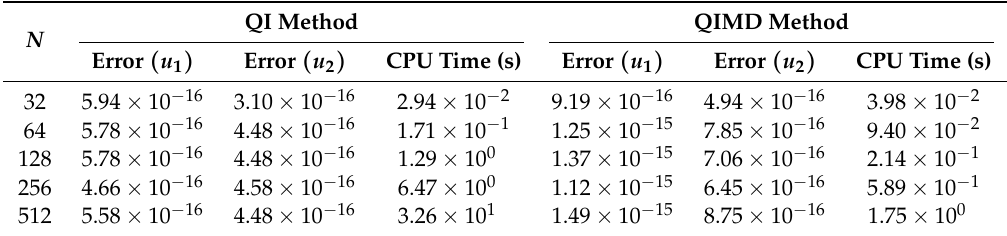
Table 3. Results of solving the coupled Helmholtz equations using the Quasi-Inverse (QI) and Quasi-Inverse Matrix Diagonalization (QIMD) methods with respect to accuracy and CPU